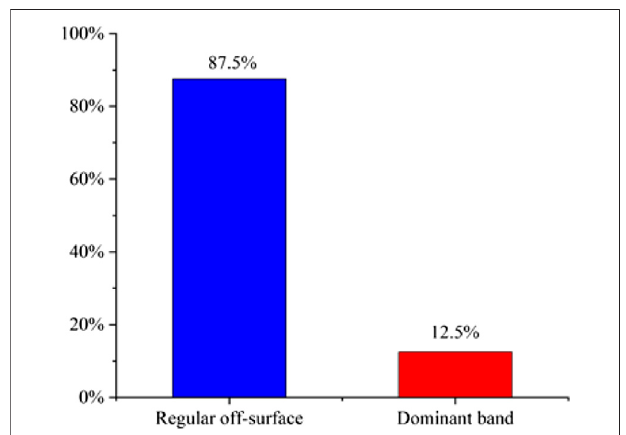
FIGURE 13 | Contribution rate of two types of